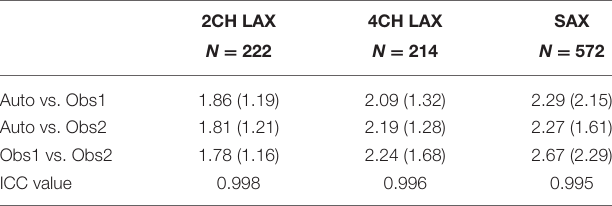
TABLE 3 | Differences and intraclass correlation (ICC) values in detecting landmarks on 50 validation